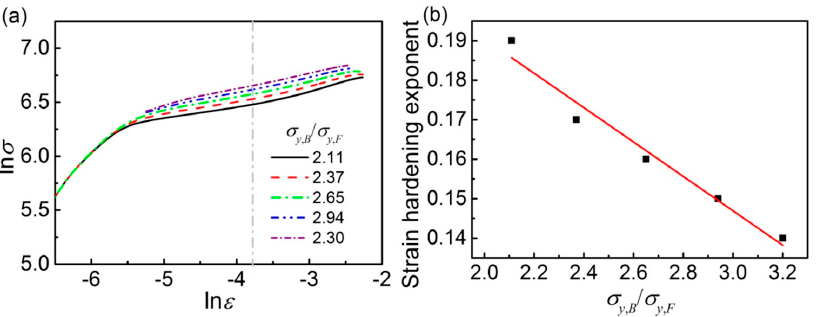
Figure 3. Influence of the σ y , B / σ y , F in mesostructure on ( a ) relationship of ln σ vs. ln ε analyzed by Hollomon analysis, and ( b ) effect of σ y , B / σ y , F .